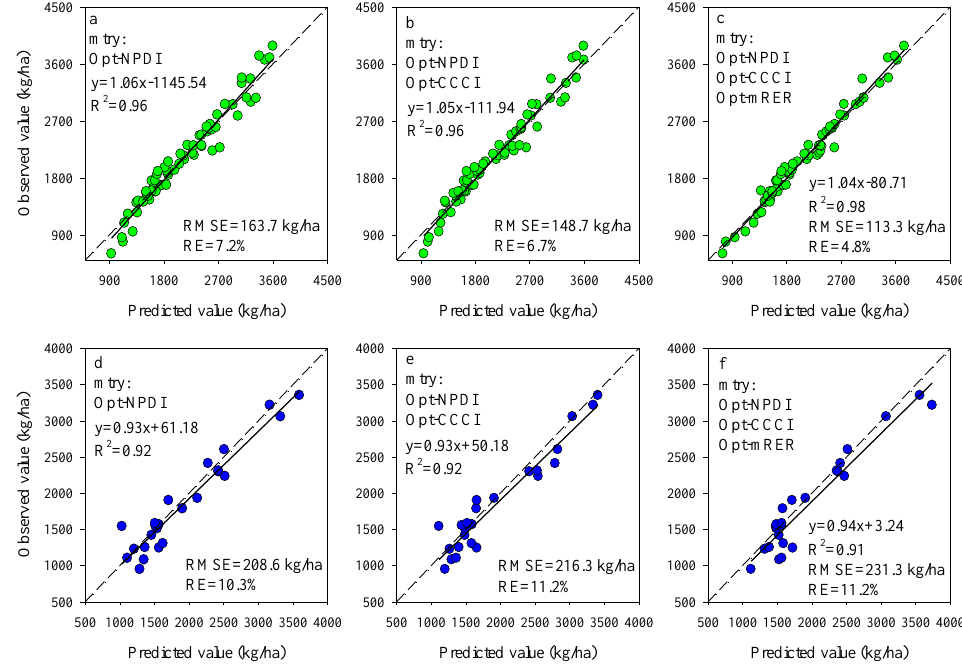
Figure 10. Optimizing the number of Opt-SIs predictors according to important scores at the tuber formation stage for training dataset ( a – c ) and testing dataset ( d – f ).